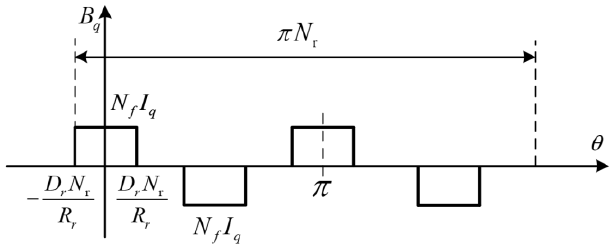
Figure 5. Spatial distribution of rotor magnetomotive force (electric angle).